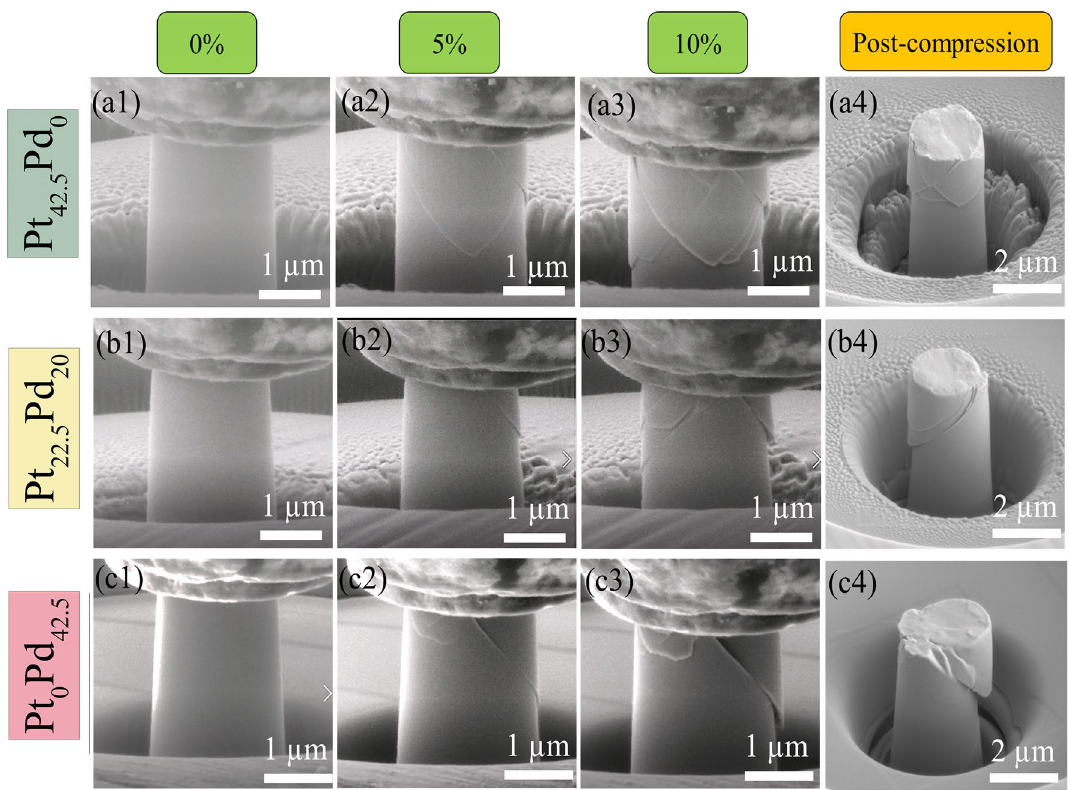
Figure 5. In-situ SEM image at strain of 0%, 5%, and 10% for micro-pillars of ( a1 – a3 ) Pt 42.5 Pd 0 , ( b1 – b3 ) Pt 22.5 Pd 20 , and ( c1 – c3 ) Pt 0 Pd 42.5 amorphous alloys; post compression SEM images for ( a4 ) Pt 42.5 Pd 0 , ( b4 ) Pt 22.5 Pd 20 , and ( c4 ) Pt 0 Pd 42.5 alloys indicating multiple shear band formation for Pt 42.5 Pd 0 in contrast to one major shear band for Pt 0 Pd 42.5